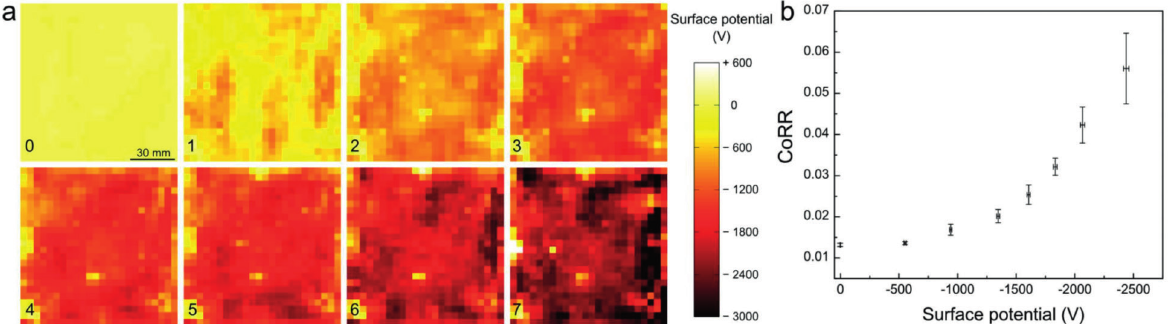
Figure 8 - Mechanism for contact triboelectrification of insulating polymers. Shearing the polymer interface heats both surfaces unevenly forming hot spots, due to forced contact on surface hills. Plasticization and melting take place added to chain breakdown and fragmentation. Homolytic scission produces free radicals with markedly different electronegativities that are converted into fluorocarbanions and hydrocarbocations by electron transfer. Ions are segregated due to the chain size, following Flory−Huggins theory and superseding weak electrostatic interactions between highly spaced charges. Reprinted (adapted) with permission from (Burgo et al. 2012). Copyright 2012 American Chemical Society.